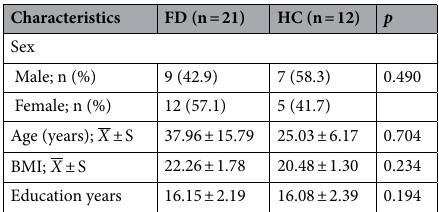
Table 1. Comparison of baseline characteristics (mean ±